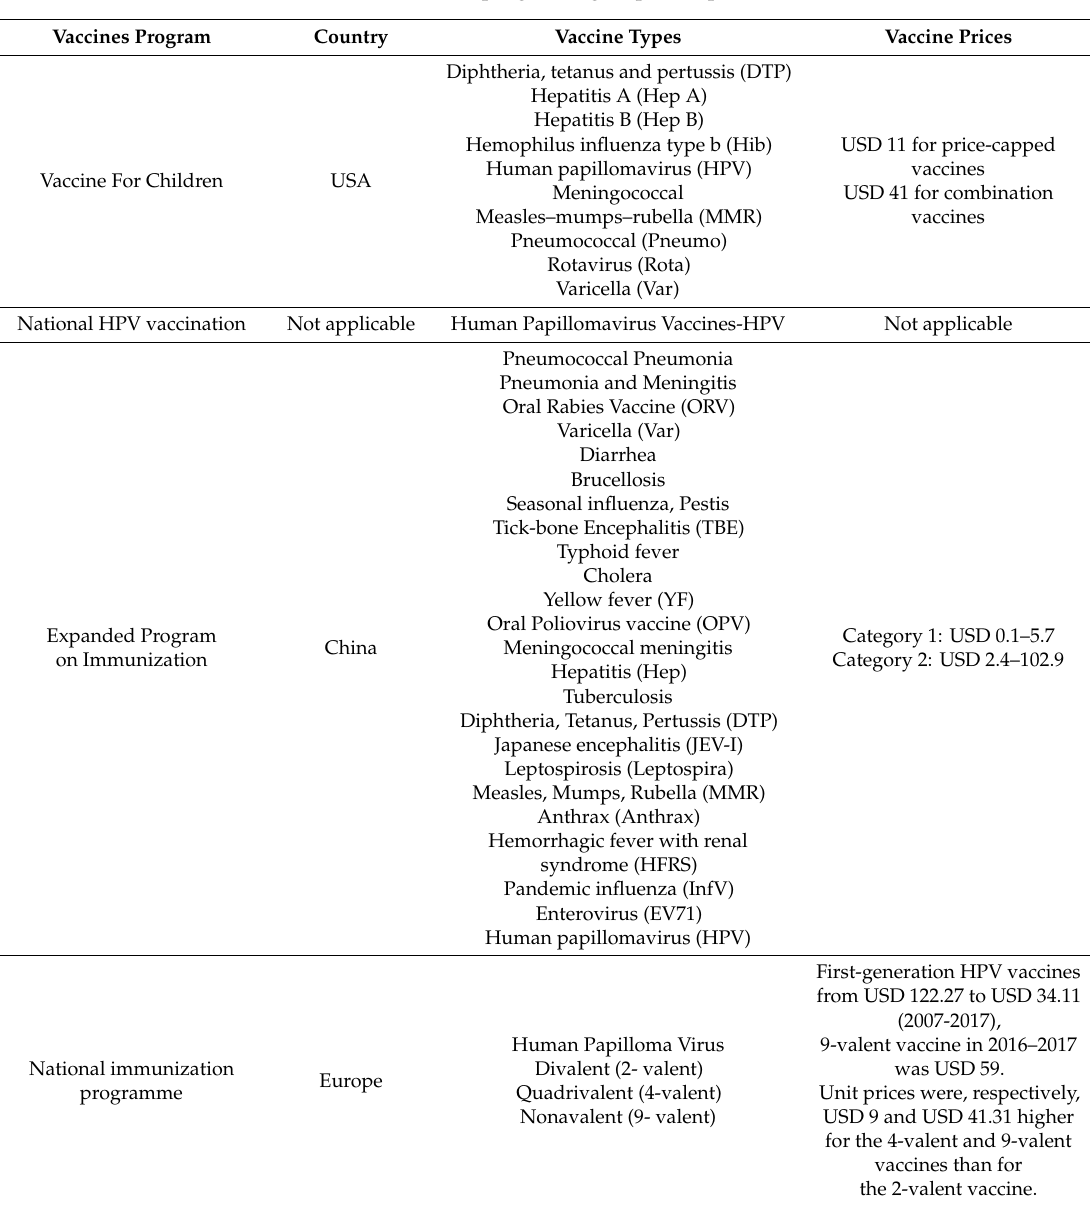
Table 3. Vaccine programs, groups and